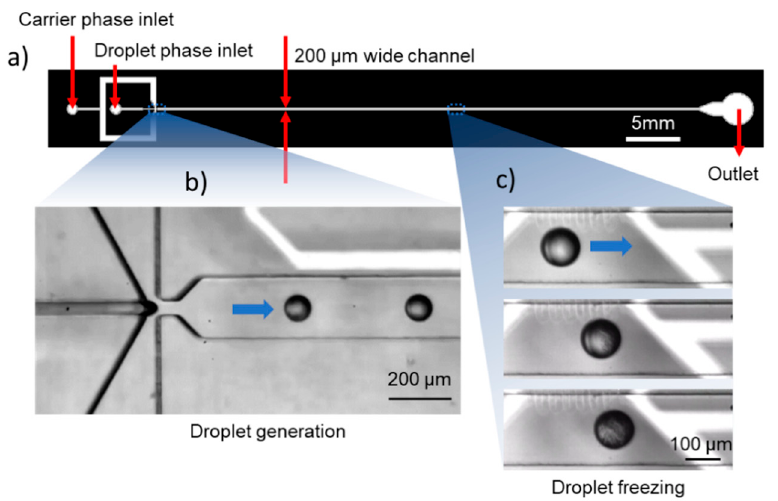
Figure 4. ( a ) Microfluidic channel design for the study; ( b ) Droplet generation at the flow-focusing junction; ( c ) Droplet ice nucleation and complete crystallization observed in the cold zone. The white region in the background is the temperature sensor underneath the flow channel.